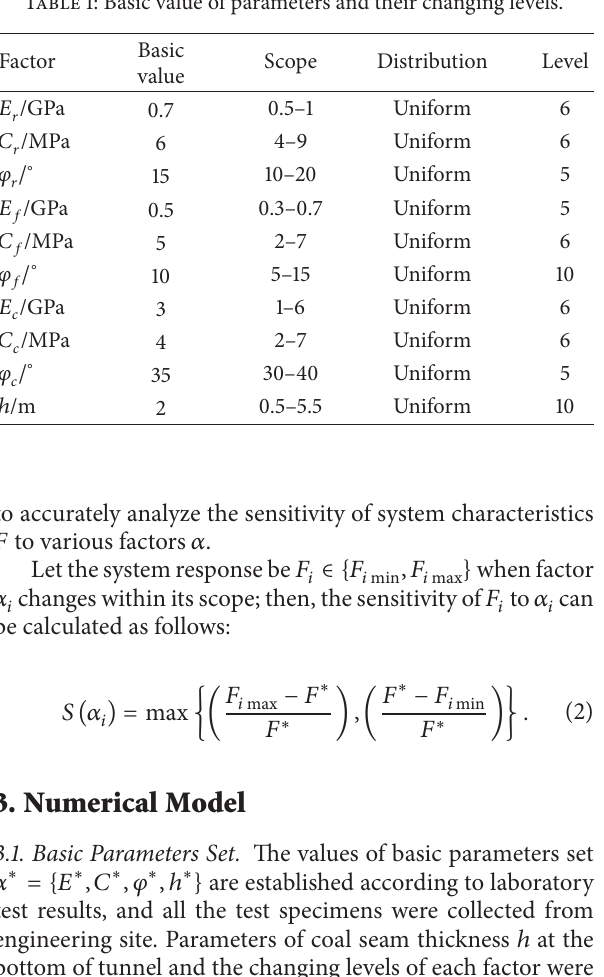
Table 1: Basic value of parameters and their changing